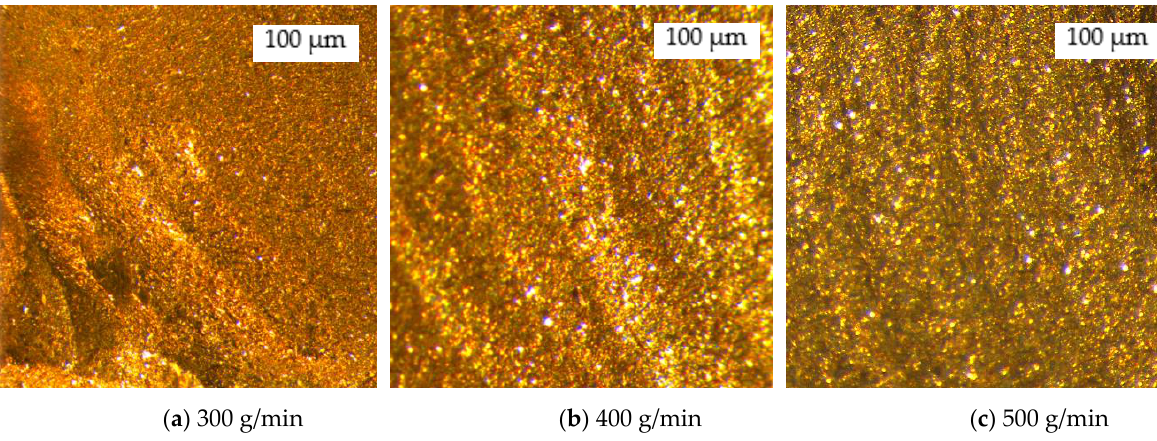
Figure 11. Topography of AISI 304L cut surface with 8 mm thickness using varied Abrasive mass flow rate.